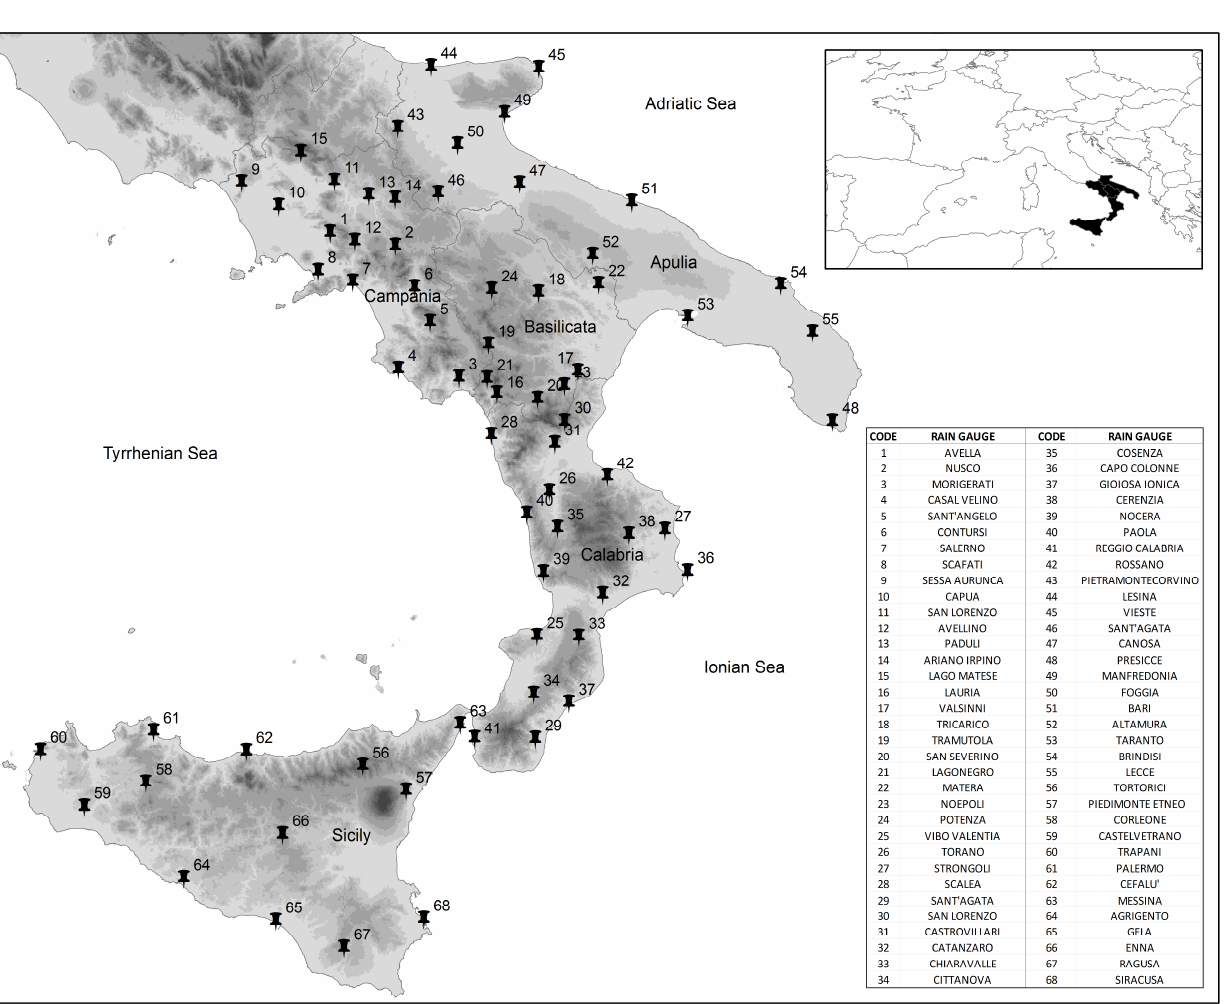
Fig. 1. Localization of the rain gauges used in the applications. Figure 1. Localization of the rain gauges used in the applications. 3